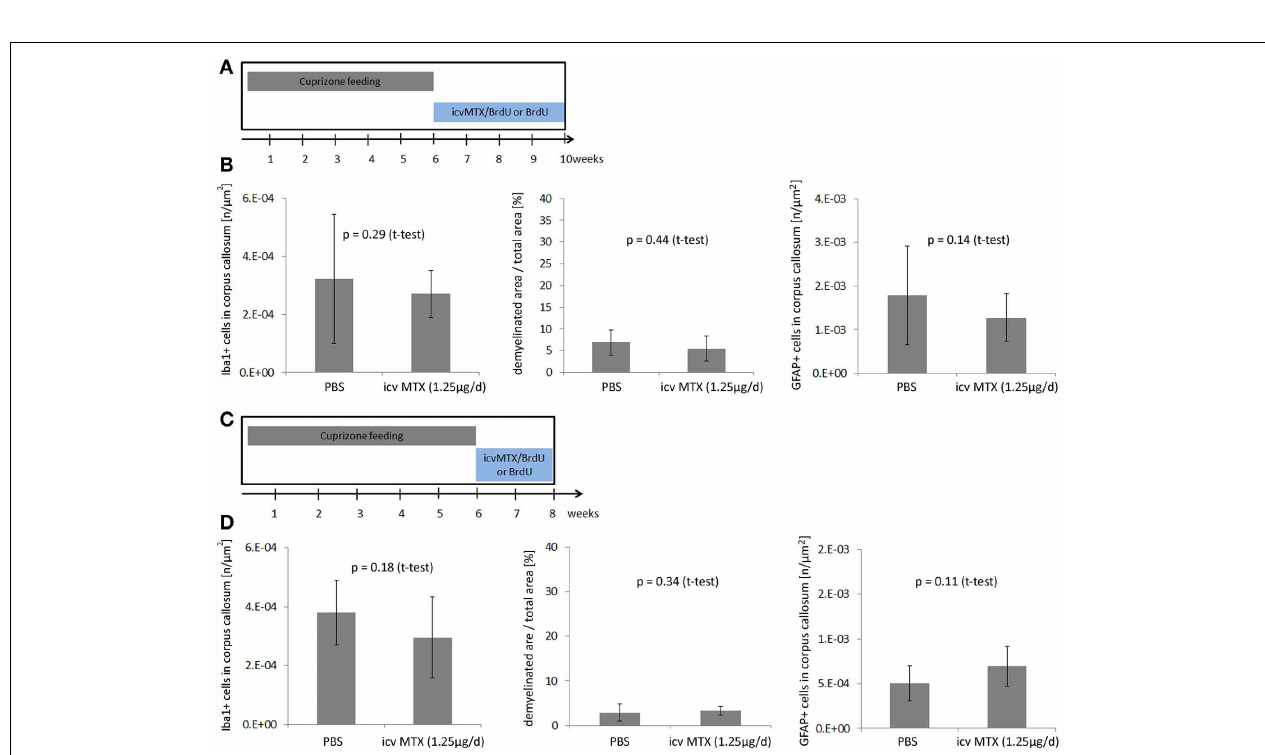
FIGURE 3 | Delayed onset of icv MTX administration does not prevent demyelination but reduces astroglial activation. (A) Eight mice per group were fed with cuprizone for a total of 6 weeks. For the last 4 weeks the mice received additionally either 1.25 µ g/day methotrexate dissolved in 10mg/mL